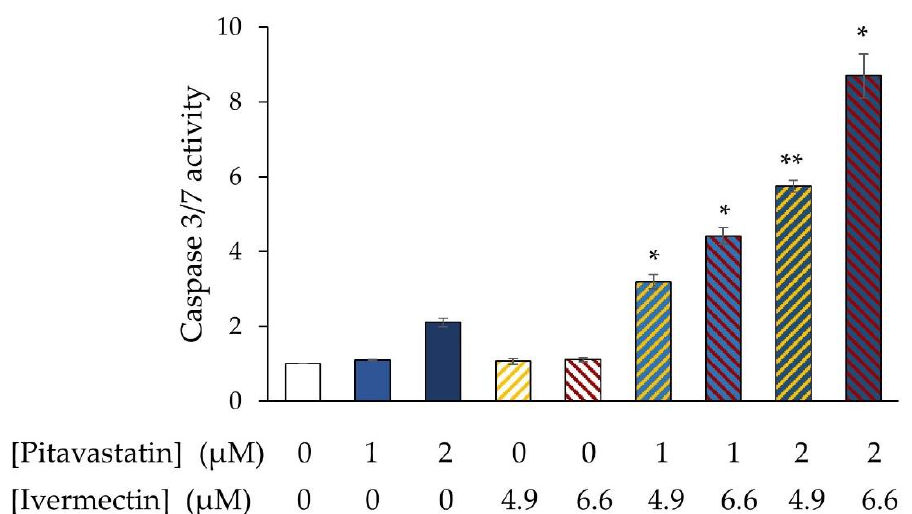
Figure 3. Evaluation of the combination of pitavastatin and ivermectin on caspase-3/7 activity. Cov-318 cells were exposed to pitavastatin (1 or 2 µ M) with/without ivermectin (4.9 µ M, 6.6 µ M, or 9.0 µ M) and after 72 h caspase 3/7 activity was measured. To control for potential effects of the drugs on cell number, the caspase-3/7 activity was normalised to the number of surviving cells estimated at the same time by staining a separate plate with SRB. The results are expressed as a proportion of the activity measured in untreated cells (mean ± SD, n = 3). The results were significantly different from those in cells treated with pitavastatin alone where indicated (*, p < 0.005, **, p < 0.001, paired t -test).